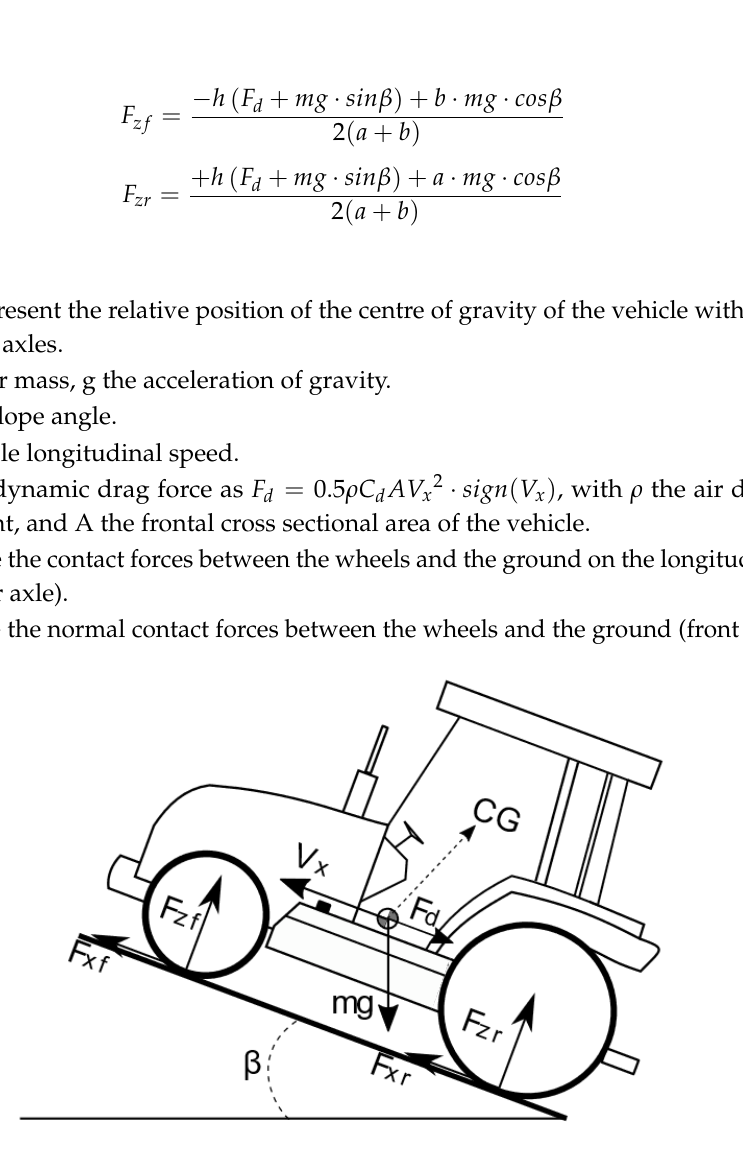
Figure 3. 1D Longitudinal model of the